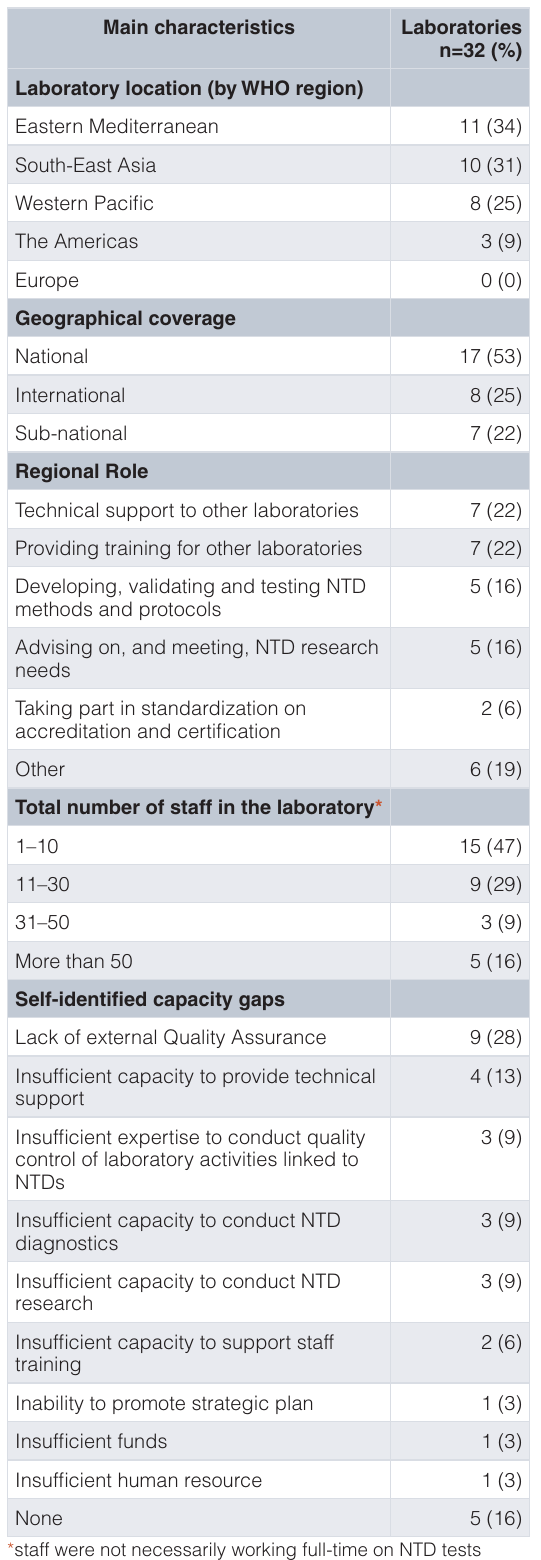
Table 1. Characteristics and distribution of potential neglected tropical disease (NTD) reference